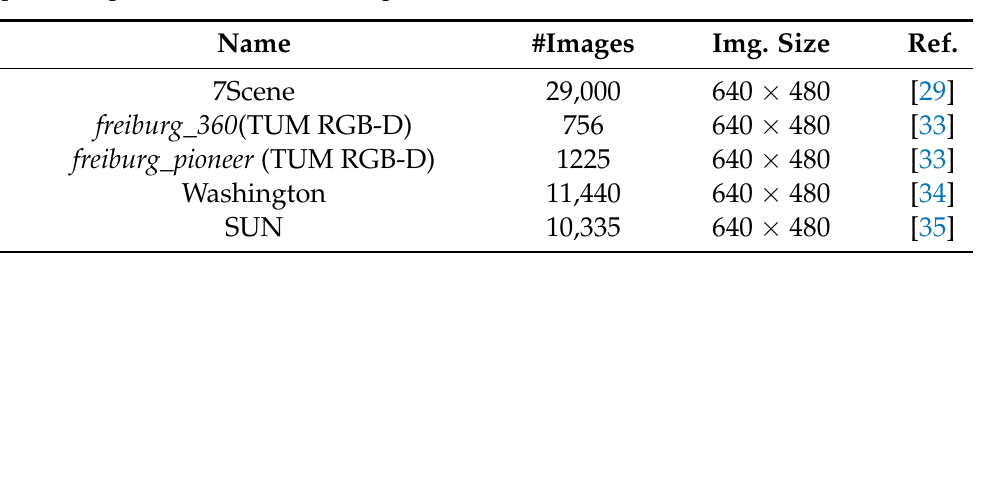
Table 2. Details of the three datasets used in the testing phase, the italic format indicates a specific sequence from the dataset specified between